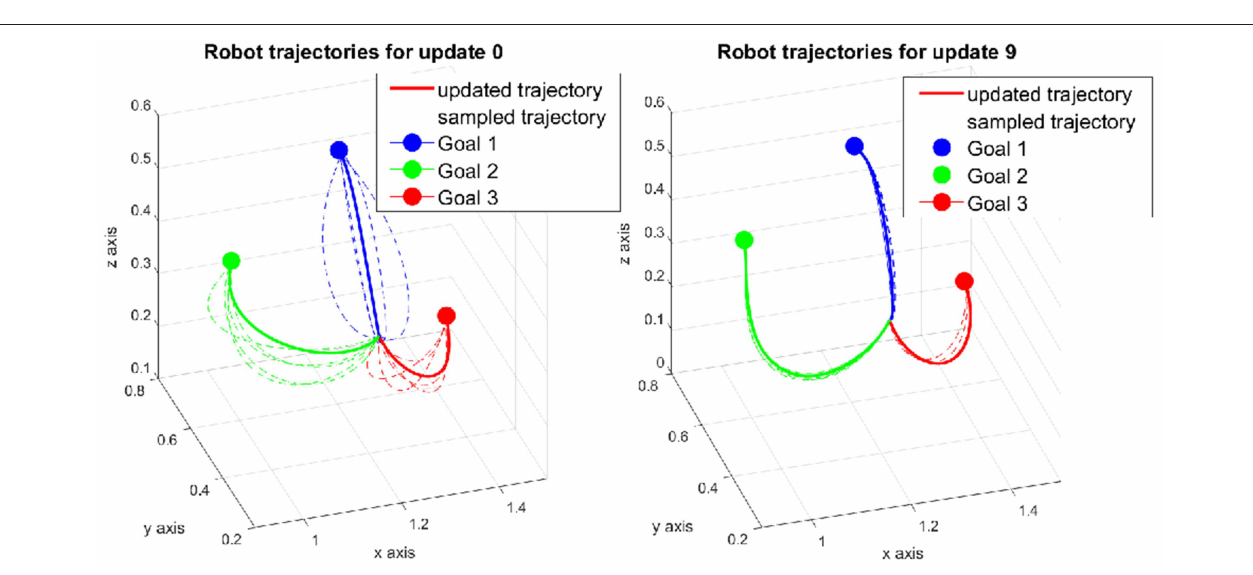
FIGURE 8 | Robot trajectories in the task generalization experiment. The trajectories were initialized by the weights generated from the regression